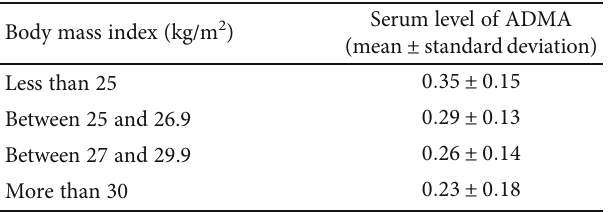
Table 4: Relationship between the serum concentration of ADMA and coronary artery slow fl ow intensity based on CTFC.